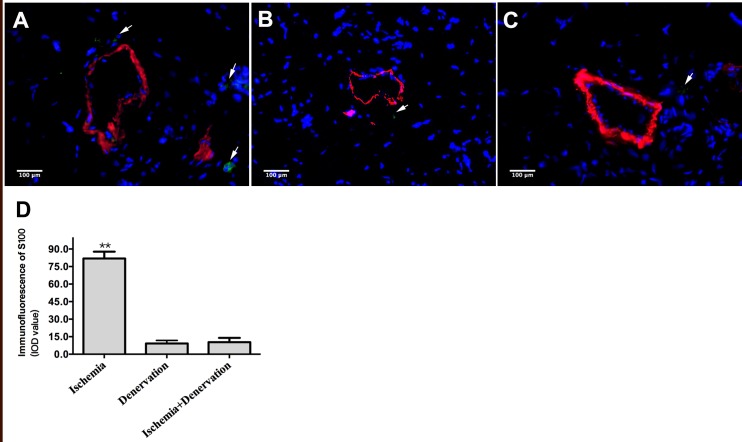
Immunofluorescence staining of the peripheral nerves.The peripheral nerve was identified using S100 and α-SM-actin immunofluorescence dual staining of gracilis muscle cross-sections from group hindlimb ischemia (HI), group simple denervation (HD) and group ischemia with denervation (HID) on day 7 post-surgery. Green indicates S100, red indicates α-SM-actin, and blue indicates nuclei. S100-positive staining which is indicated with white arrows in group HI (A) was significantly higher than both group HD (B) and group HID (C). The S100-positive staining was evaluated as integrity of density (IOD) value (D). ** p<0.01.